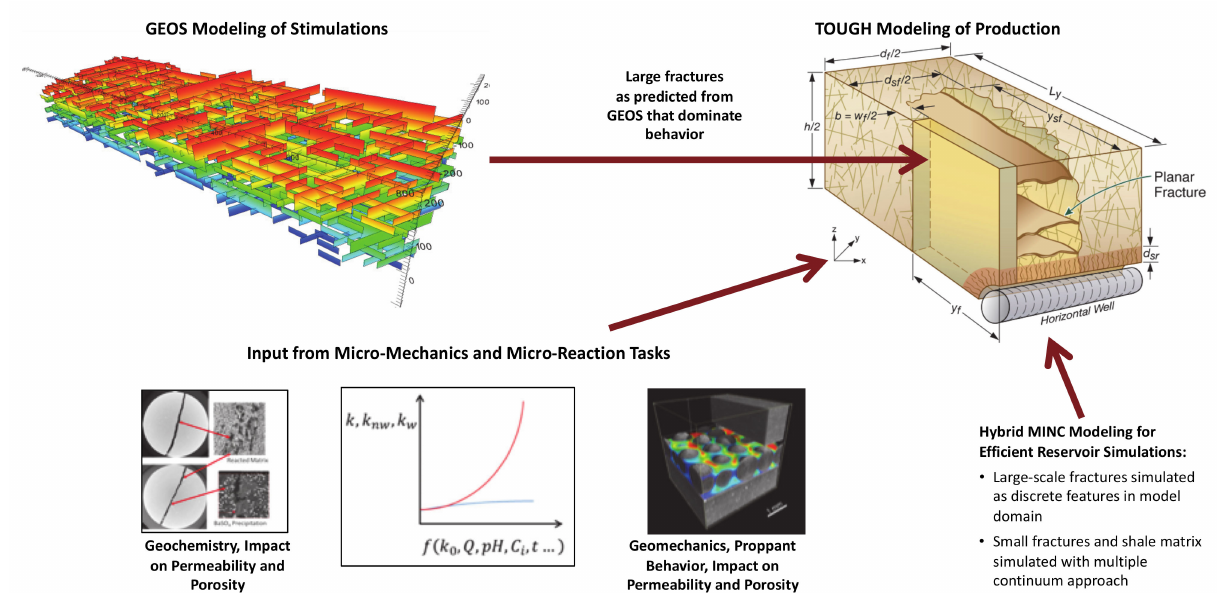
Figure 1. Schematic showing the framework for reservoir-scale stimulation and production simulations informed by micro-scale